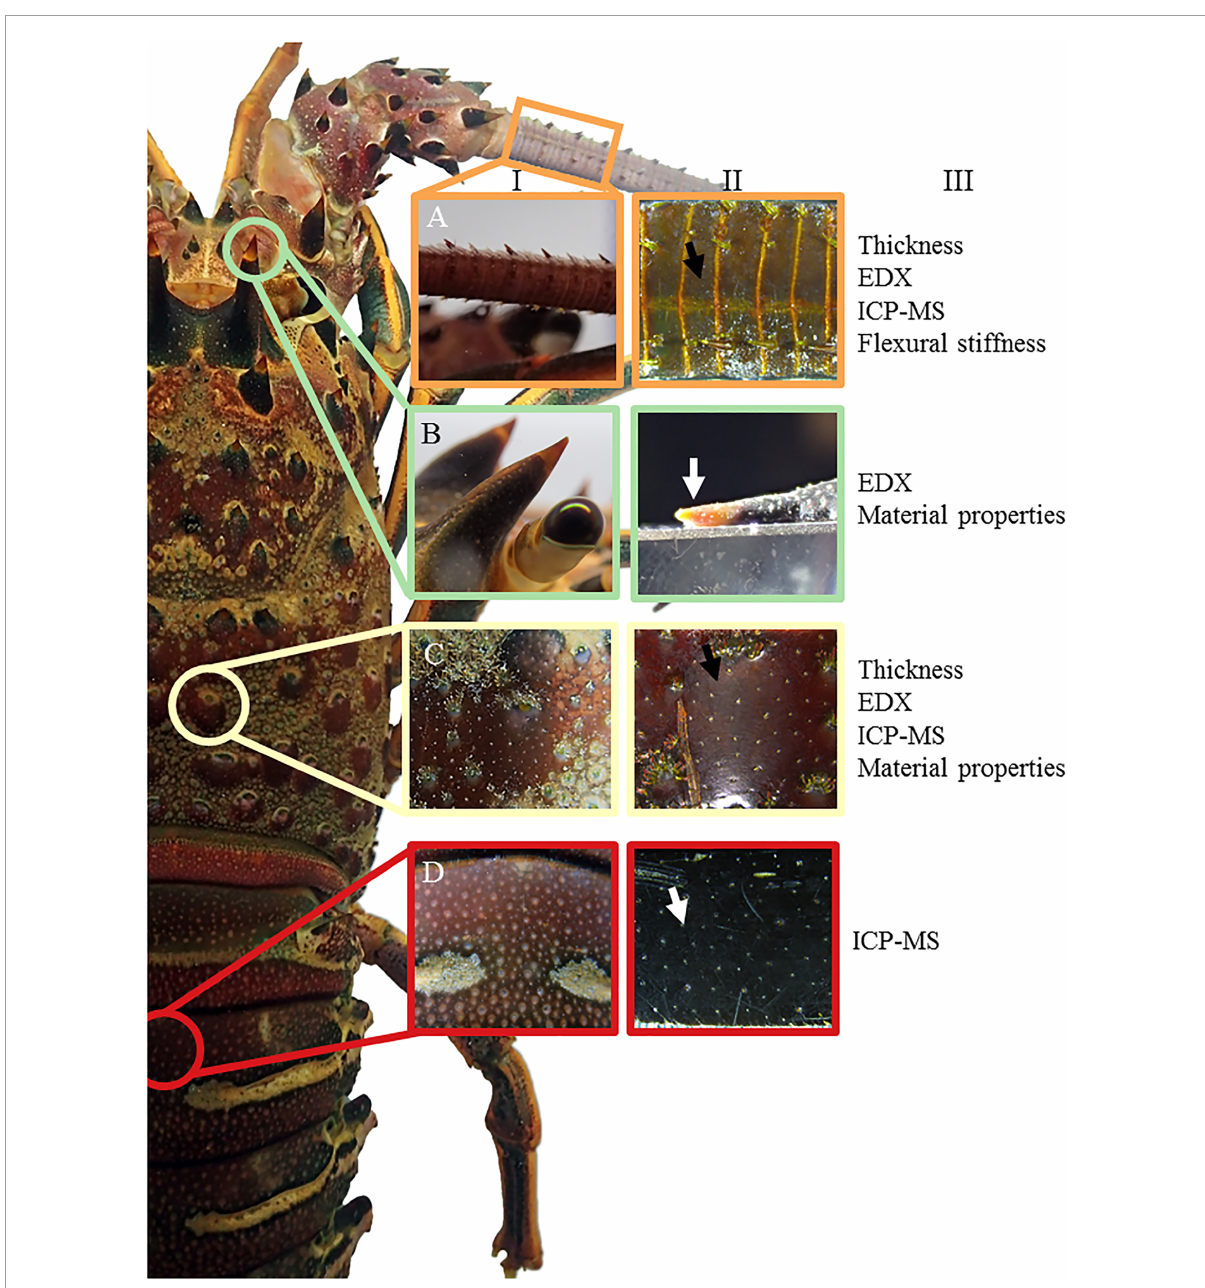
FIGURE 1 Exoskeletal defense structures of Panulirus interruptus . (A) antenna, (B) horn tip, (C) carapace spine, (D) abdominal segment in image columns I and II. The analyses performed for each structure are listed in column III. Arrows indicate areas where nanoindentation was performed normal to the surface. The horn tip in B-II is affixed to an aluminum block for